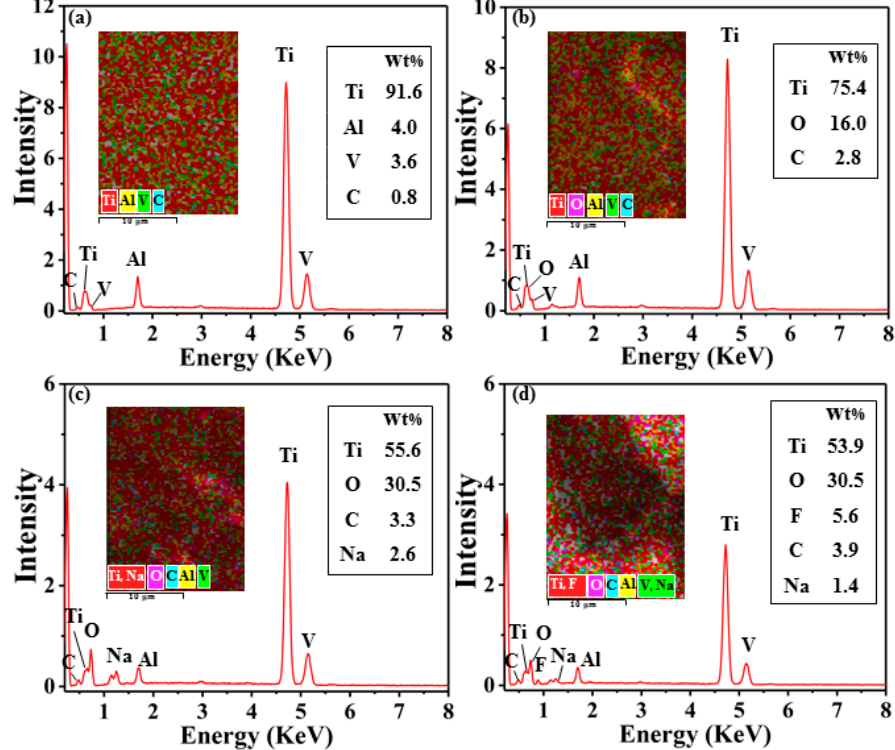
Figure 3. EDS pattern and chemical composition of different surface reaction methods: ( a ) polished surface; ( b ) WEDM surface; ( c ) WEDM-AH surface; ( d ) fluorosilane modified WEDM-AH surface.